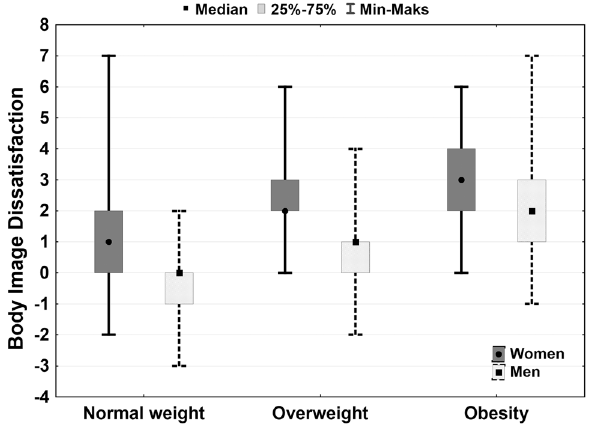
Figure 3. Influence of body weight and gender on body dissatisfaction in groups of men and